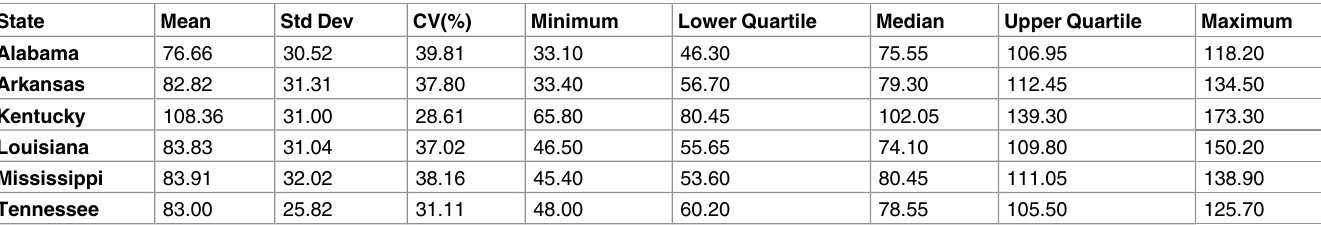
Table 8. Summary statistics for lung cancer incidence rates in the Mid-South states, 1999–2012 (cases per